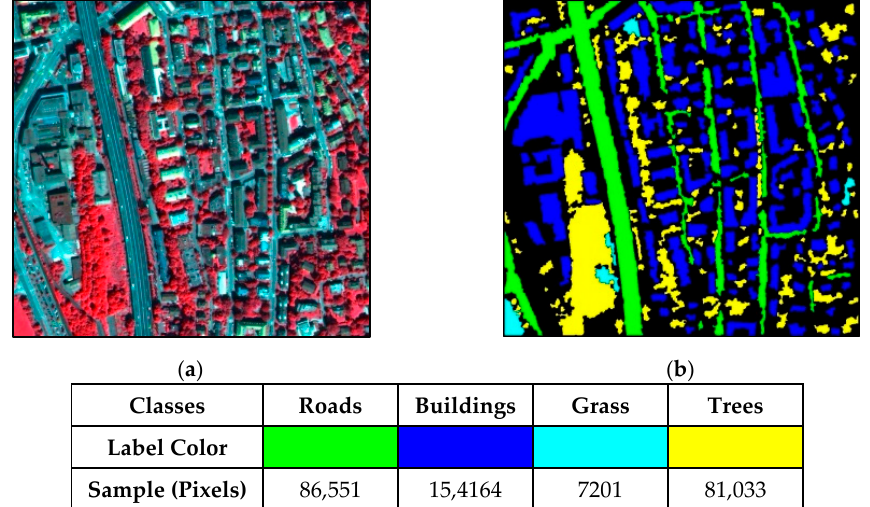
Figure 1. Zurich Dataset 1: ( a ) color-infrared composite (R: band 4; G: band 3; B: band 2) of the QuickBird imagery and ( b ) its reference map.